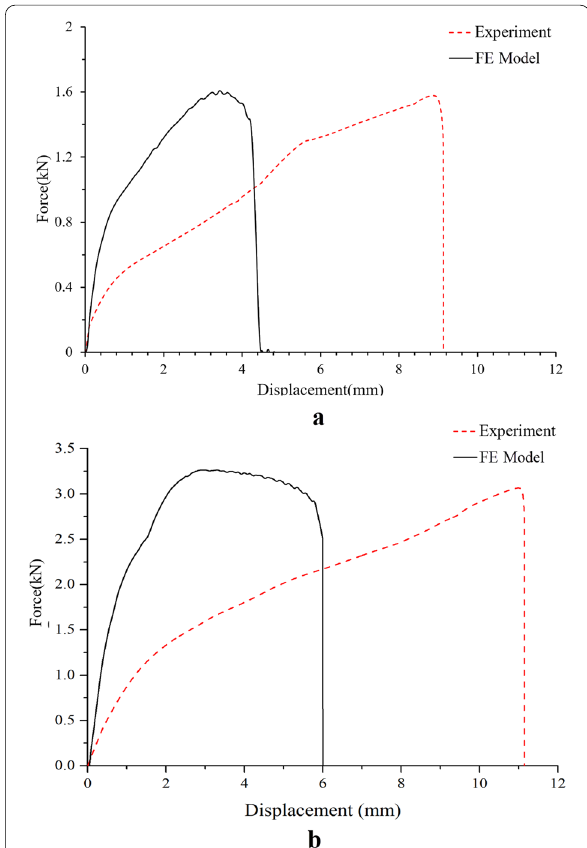
Figure 8 Comparison of force-displacement curve from FEM and experiment ( a ) SPR-A joint, ( b ) SPR-B joint